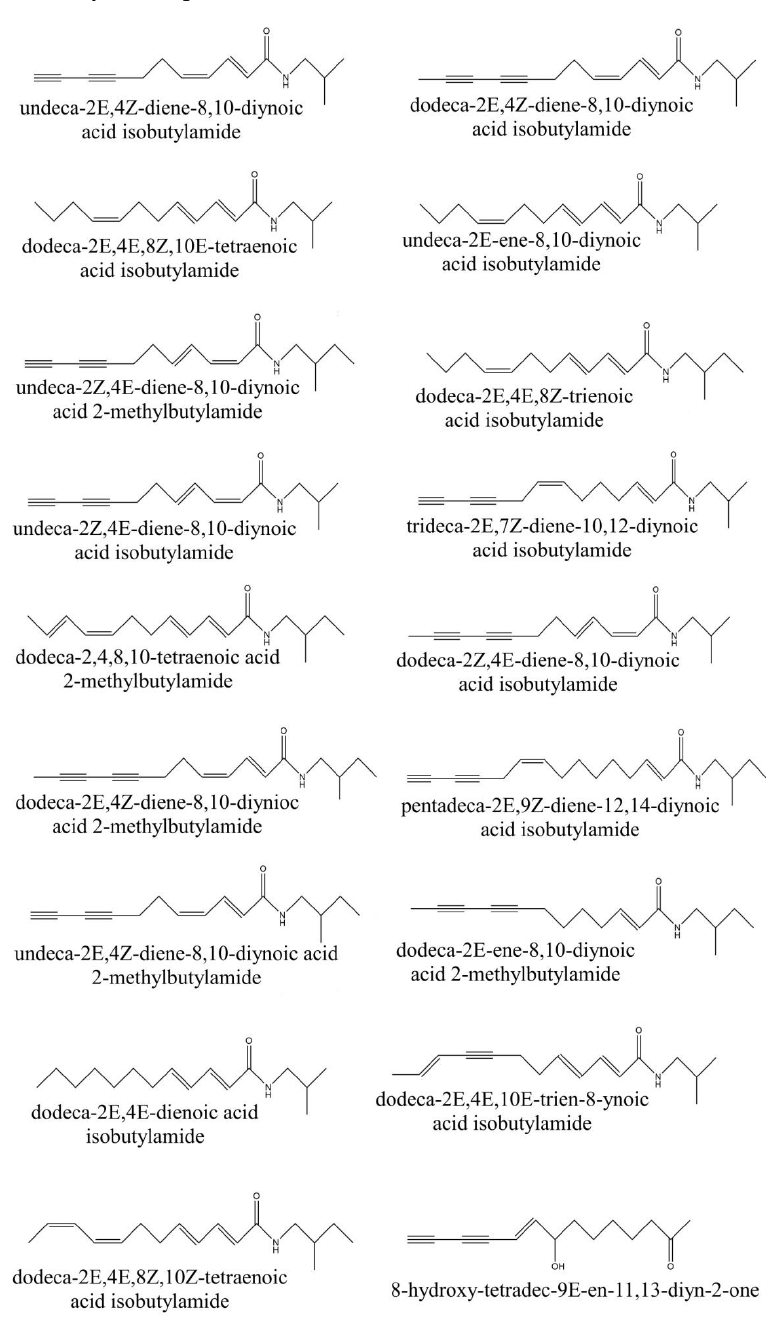
Figure 2. Chemical structures of alkamides found in Echinacea purpurea (original).